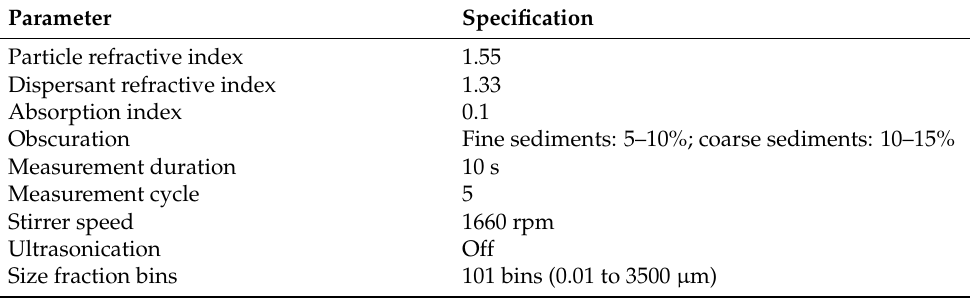
Table 2. Malvern Mastersizer 3000 instrument settings adopted for this study. Parameter